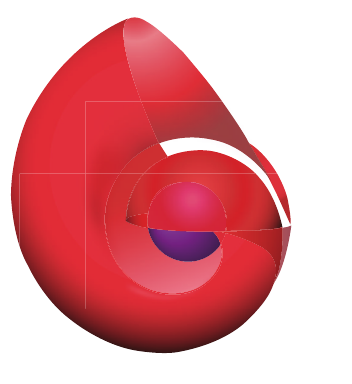
Figure 9: Generalized offset surface with the variable offset direc-